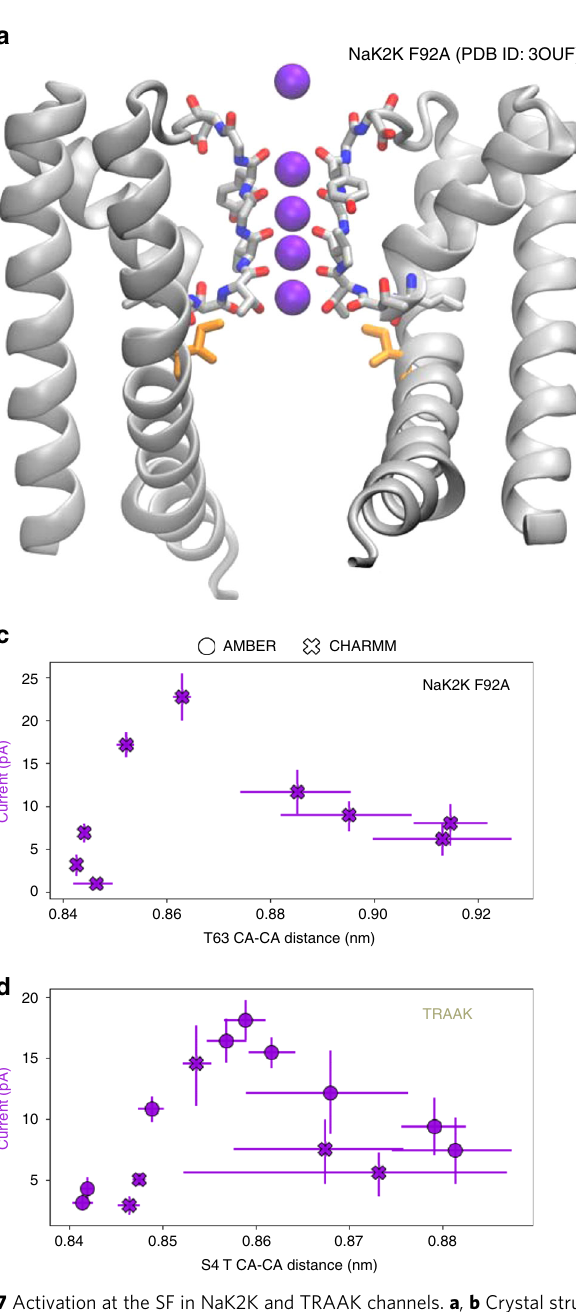
Fig. 7 Activation at the SF in NaK2K and TRAAK channels. a , b Crystal structures of NaK2K (F92A mutant) and TRAAK channels, respectively. Isoleucine residues, equivalent to I84 in MthK, are shown as orange sticks. For the overlay with the MthK structure, see Fig. S12. c , d Outward K + currents through NaK2K and TRAAK at 300 mV as a function of SF opening at S4, respectively (analogous to Fig. 2 for MthK). In NaK2K, S4 is formed by T63. In TRAAK, which is a dimer, S4 is formed by T129 and T238. Error bars represent 95% con fi dence intervals. Source data are available as a Source Data fi